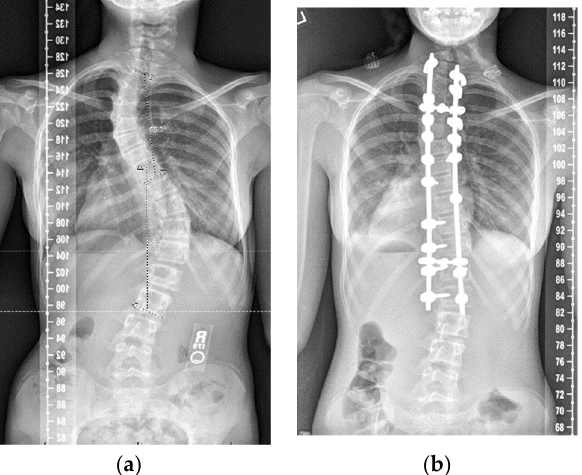
Figure 3. ( a ) Patient with PT curve of 55° and MT curve of 57°. Their PreTCR is 0.96. ( b ) T2-L1 posterior spinal fusion with PostPCR 0.64 and TCCR 0.66. There is continued T1 tilt and the left shoulder is high.